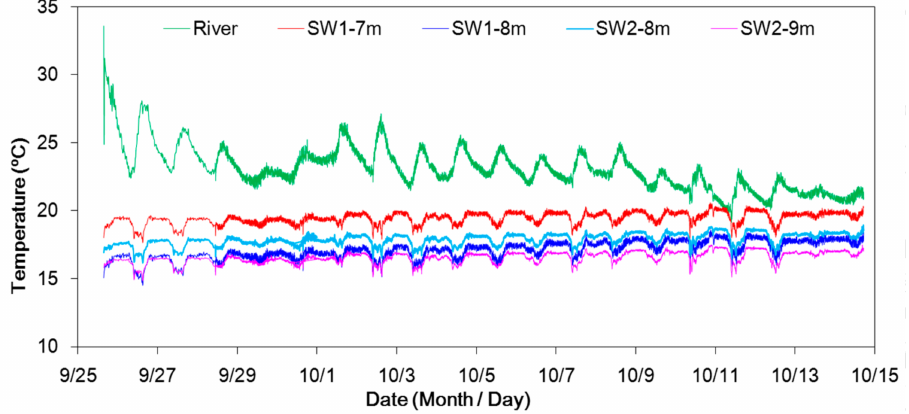
Figure 4. River water temperature and groundwater temperature from 25 September to 15 October 2014 at the depths of 7 and 8 m of sampling well 1 (SW1-7 m and SW1-8 m), and at the depths of 8 and 9 m of sampling well 2 (SW2-8 m and SW2-9